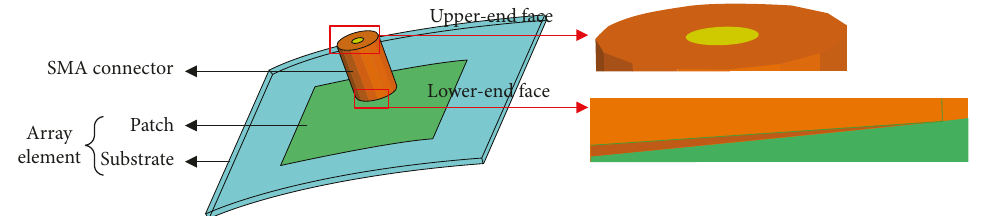
Figure 9: Antenna element model fi tted by the FEM software.